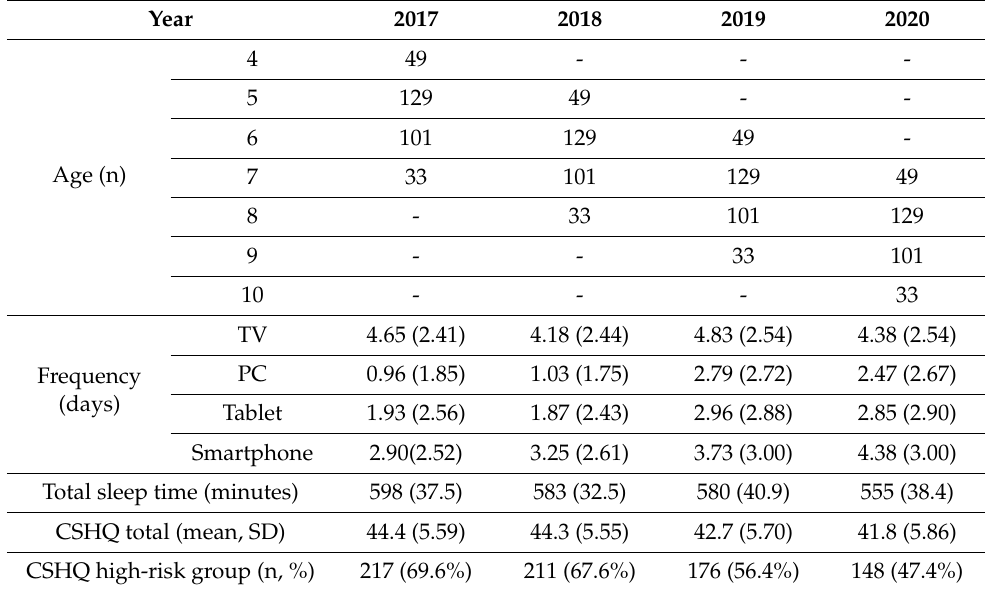
Table 2. Year-by-year changes in screen frequencies and sleep